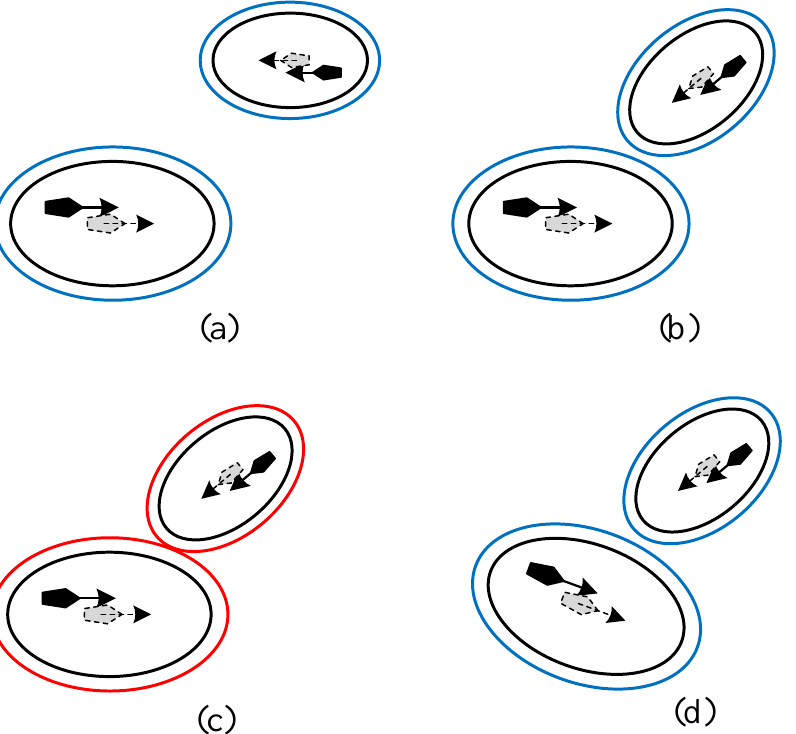
Figure 12. Collision avoidance in close-quarters situations: ( a ) scenario 1, ( b ) scenario 2, ( c ) scenario 3, and ( d ) scenario 4.